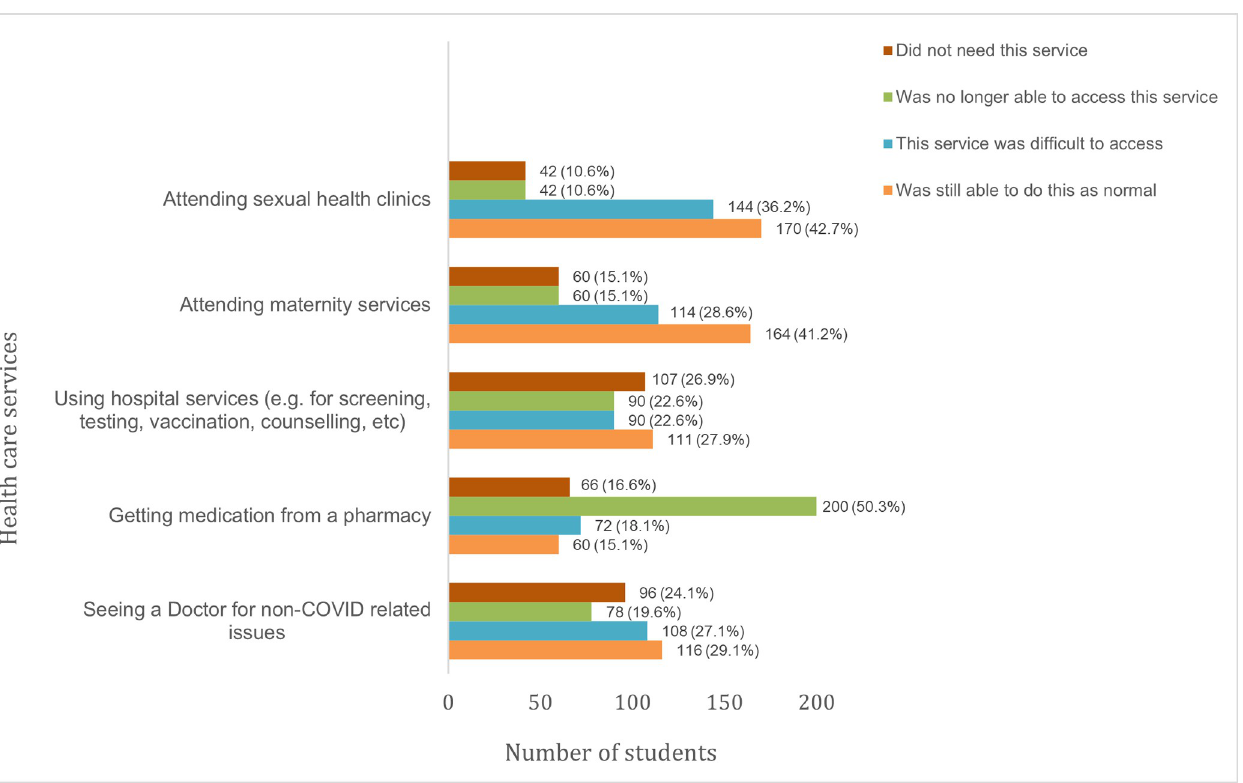
Fig 7. Students’ access to and use of health services during the lockdown.